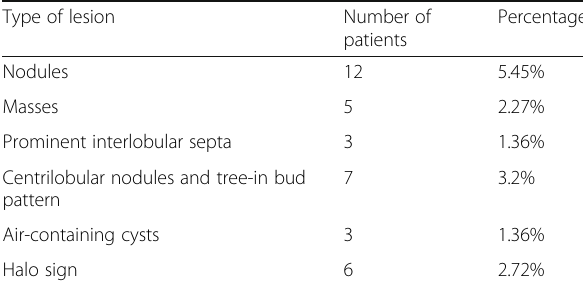
Table 4 Summary of uncommon lesions